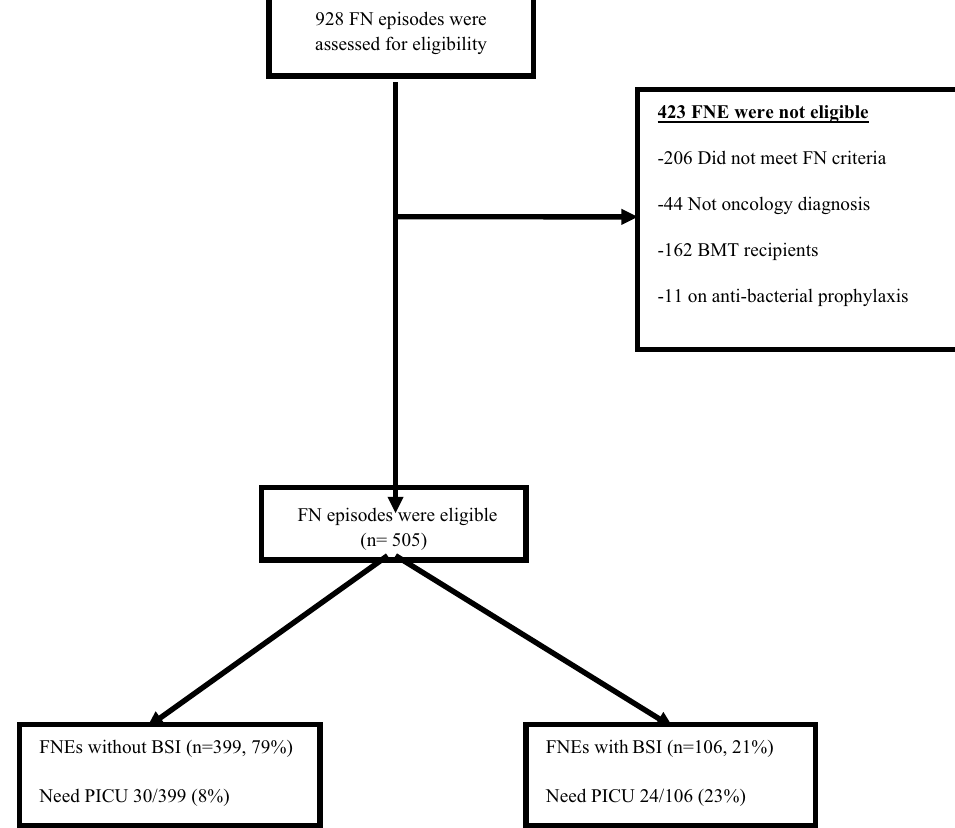
Figure 1. Study flow diagram. Febrile neutropenia (FN) with and without BSI and need to PICU. FNE Febrile neutropenia episodes, BSI blood stream infection. PICU pediatric intensive care, BMT bone marrow